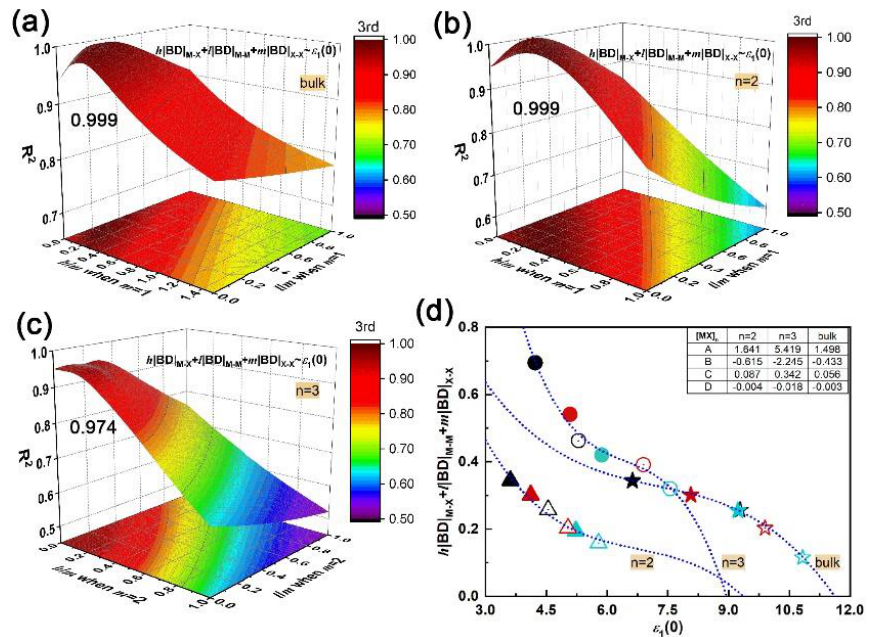
Figure 4. Fitting h | BD | M–X + l | BD | M–M + m | BD | X–X vs . ε 1 (0) via equation y = A + Bx + Cx 2 + Dx 3 by adjusting h / m and l / m ratios: ( a ) coefficient of determination (R 2 ) of bulk; ( b ) bilayer; ( c ) trilayer; ( d ) fitting curves and coefficients A, B, C, D at the maximum R 2 . Symbols used in the ( d ) plot, solid: GaX, hollow: InX; black, red and teal colors: X = S, Se and Te, respectively; triangles, circles and stars: n = 2, 3 and bulk, respectively.